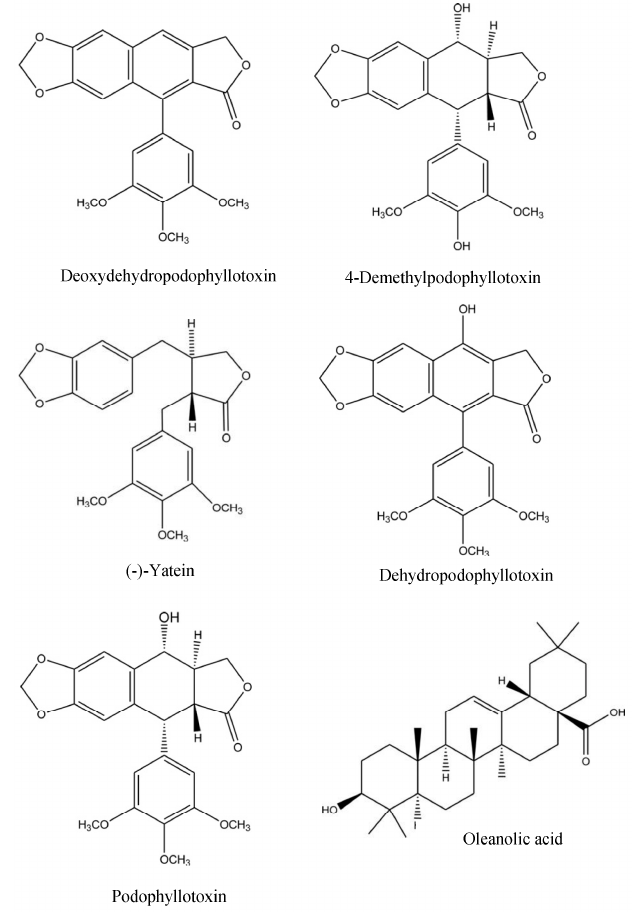
Figure 3. Structures of phytochemicals identified in the aqueous extract of H. verticillata (aerial, dried). Table 1. LC-MS * and RP-HPLC analysis and summary.